Question: Does the figure show an increasing or a decreasing trend?
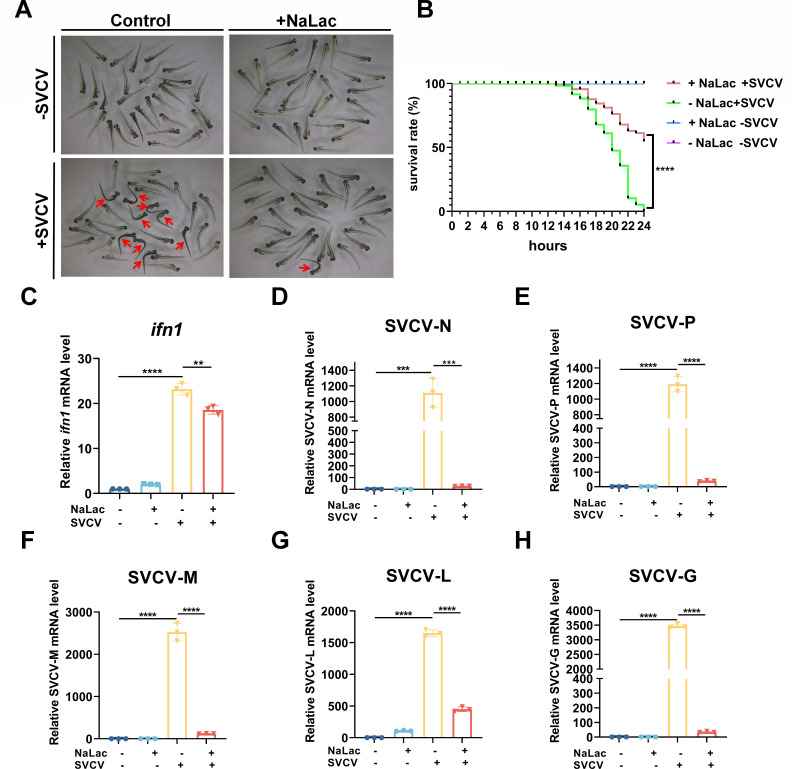
Answer: increasing